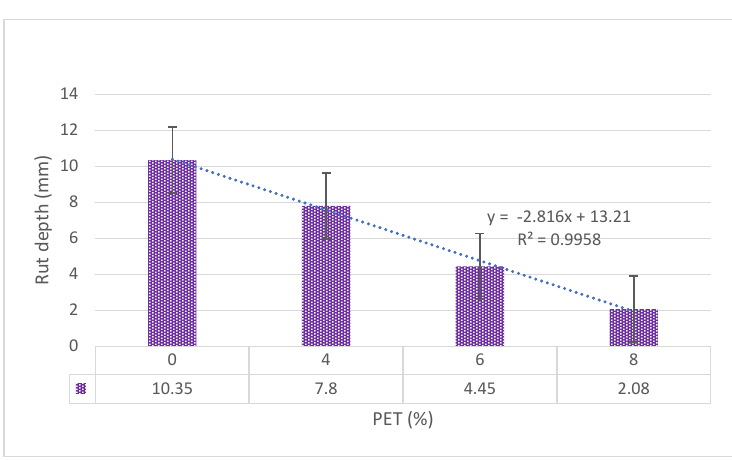
Figure 12. Rutting of PET-modified AC mixtures.